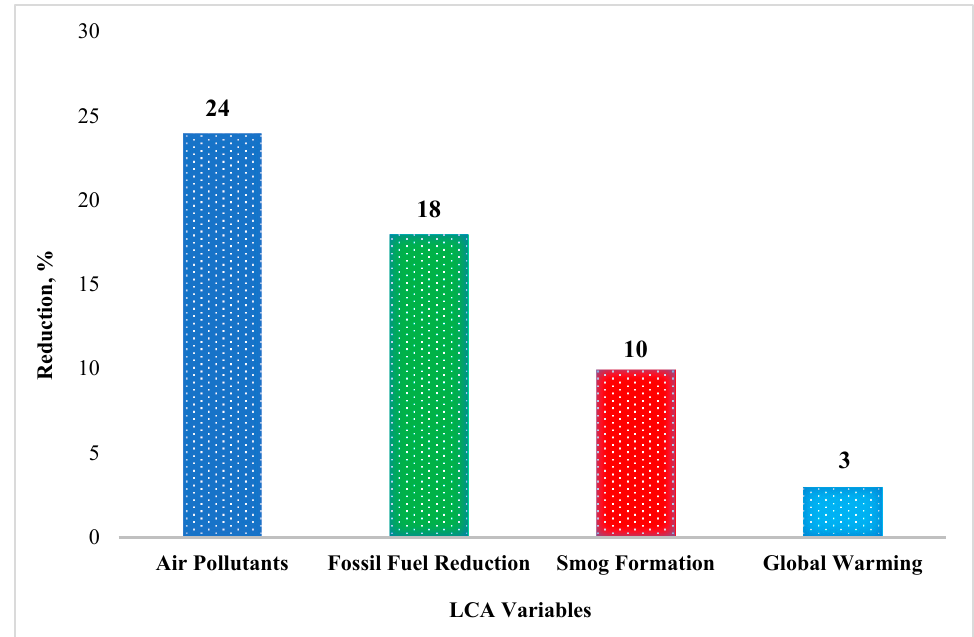
Figure 5. Reduction in different LCA categories.